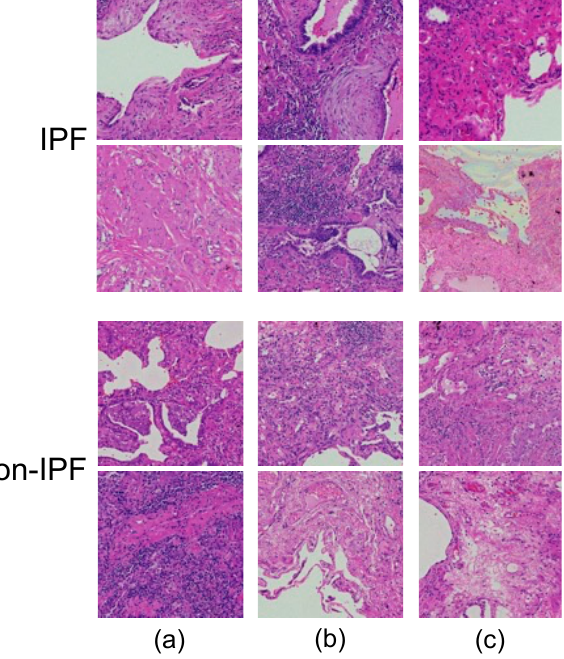
Figure 7. Classified images using the proposed method. ( a ) Correctly classified with and without PGGAN; ( b ) Correctly classified with PGGAN; ( c ) Incorrectly classified with and without PGGAN.